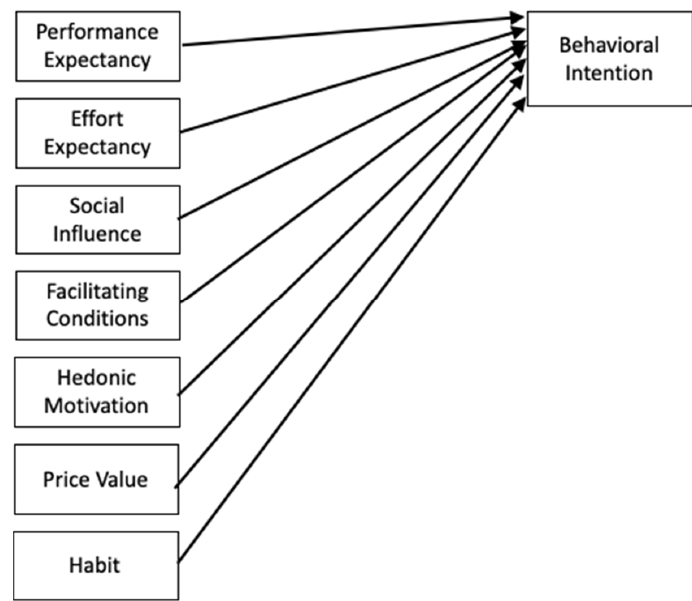
Figure 1. Construct relationship model for the study. Note . Adapted from “Consumer Acceptance and Use of Information Technology: Extending the Unified Theory of Acceptance and Use of Technology” by V. Venkatesh, J. Y. Thong, and X. Xu, 2012, MIS Quarterly , 36 (1), pp. 157–178. Copyright © 2012, Regents of the University of Minnesota. Adapted with permission.